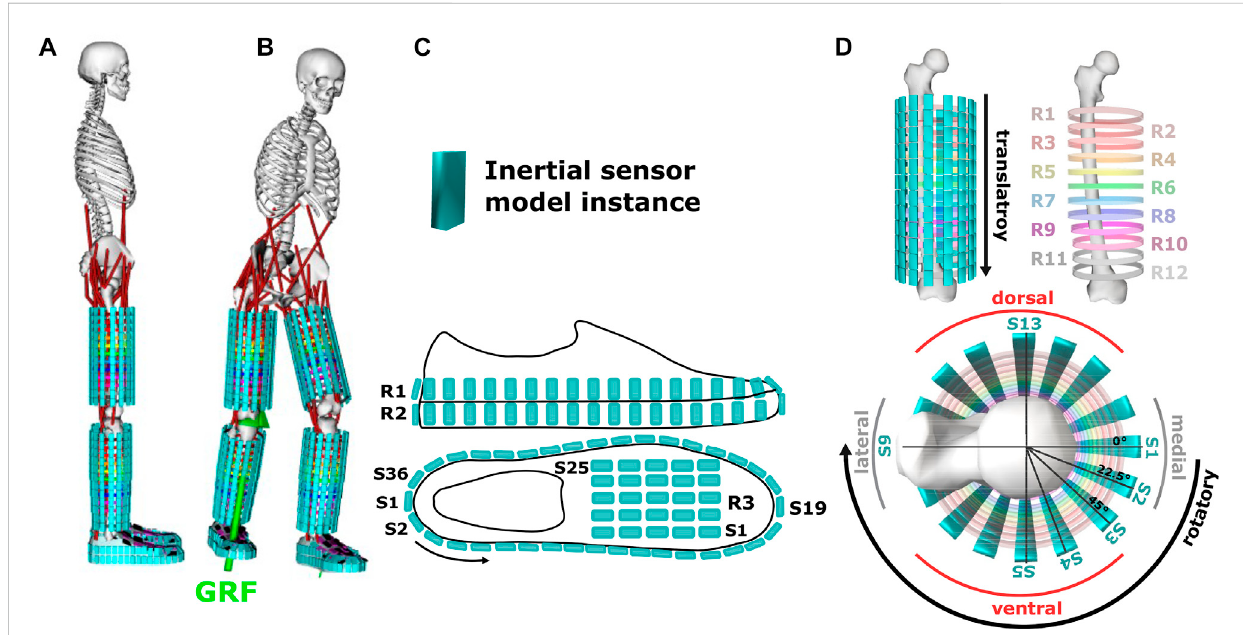
FIGURE 3 (A) Illustration of inertial sensor models attached to a biomechanical body model and a shoe model. The body model uses an auxiliary structure of rings (R) to approximate the limb silhouette. (B) Movement simulation inside OpenSim using ground reaction force data (GRF) as reference. (C) Shoe sensor positions. (D) Sensor positions (S) on the upper and lower legs and visualisation of sensor repositioning along transversal (rotatory part) and longitudinal (translatory part) limb axis of body